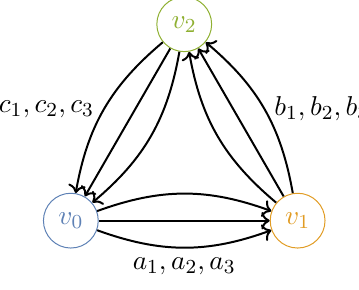
Figure 27. Quiver for local P 2